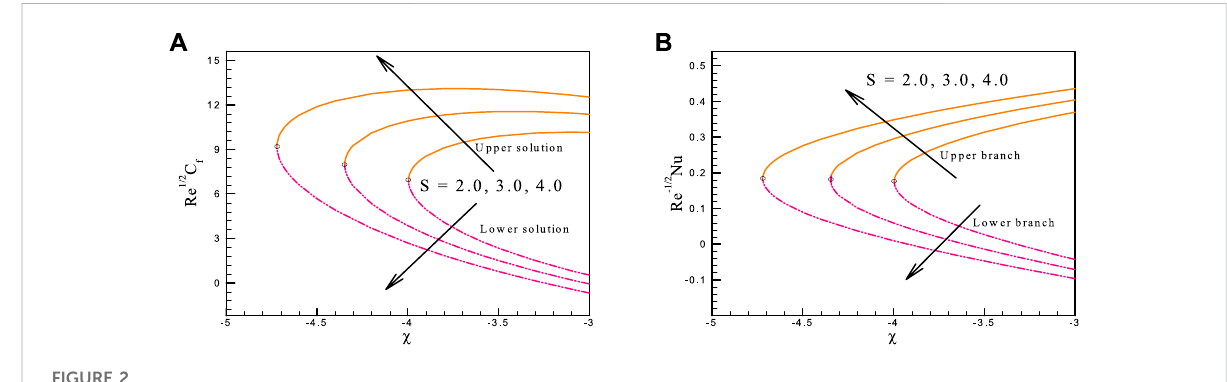
FIGURE 2 Interpretation of Re 1 2 C f and Re − 1 2 Nu for distant values of S .